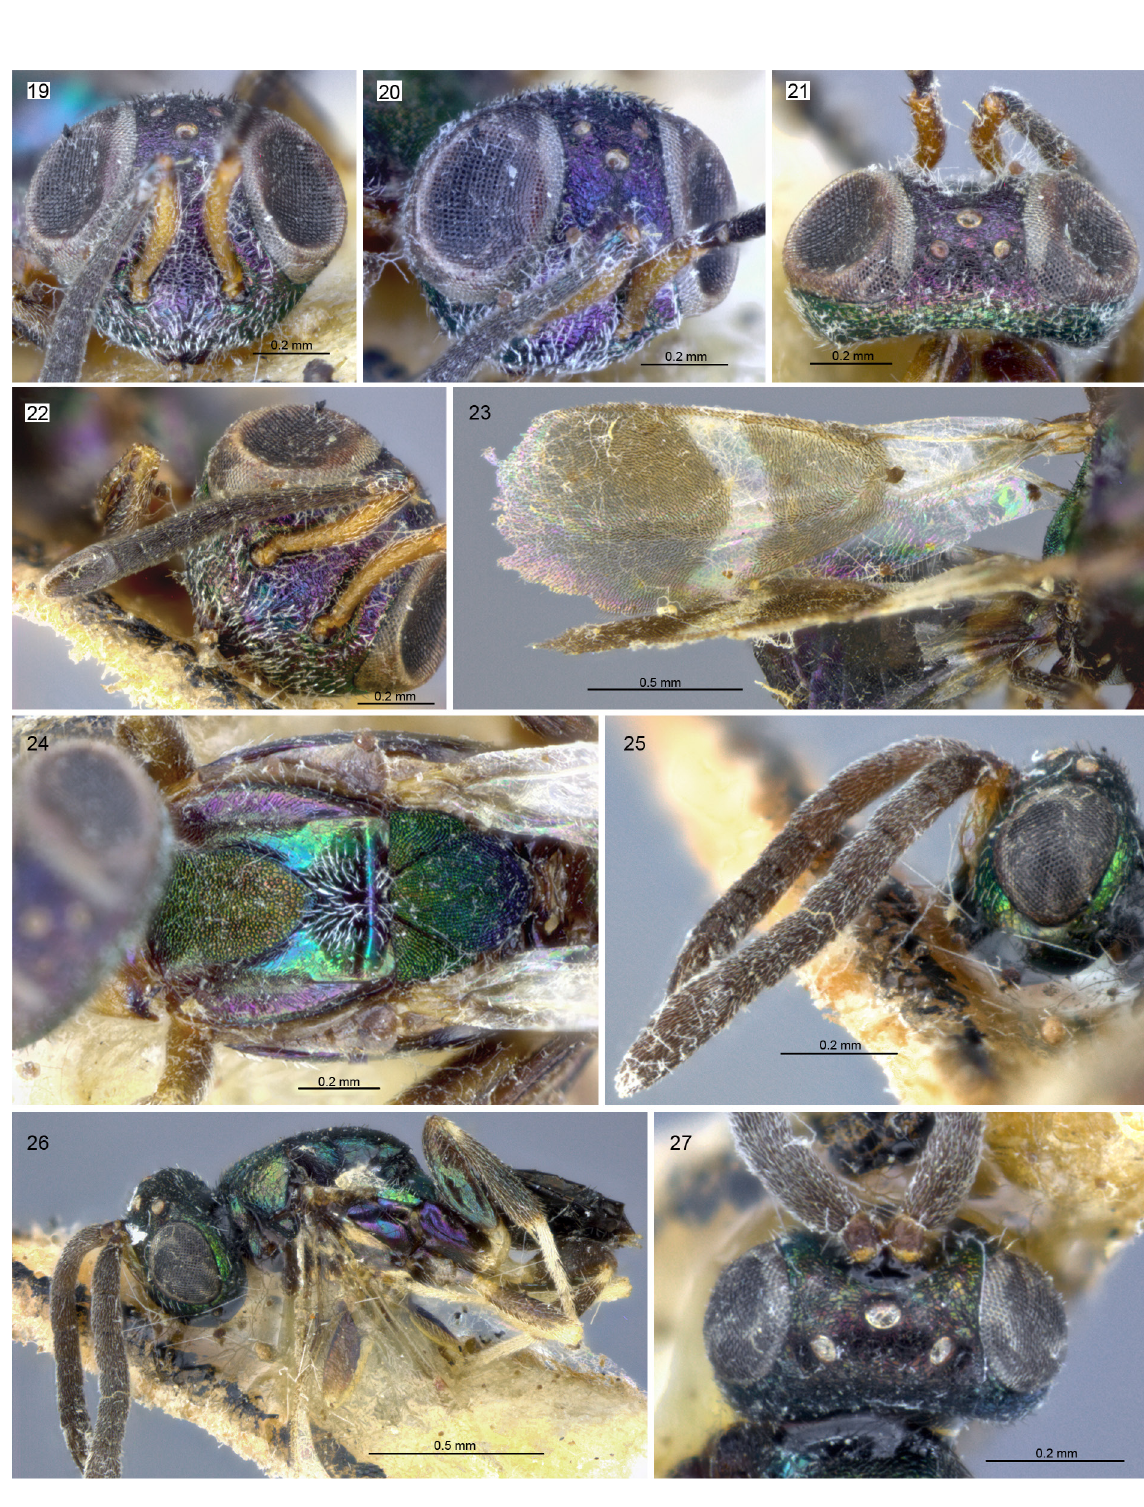
Figs 19–27. Anastatus fulloi Sheng & Wang, 1997. 19–24 . Holotype, ♀. 25–27 . Allotype, ♂. – 19 . Head, frontal view. 20 . Head, frontolateral view. 21 . Head, dorsal view. 22 . Antennae. 23 . Fore wing. 24 . Mesonotum. 25 . Antennae. 26 . Body, lateral view. 27 . Head, dorsal